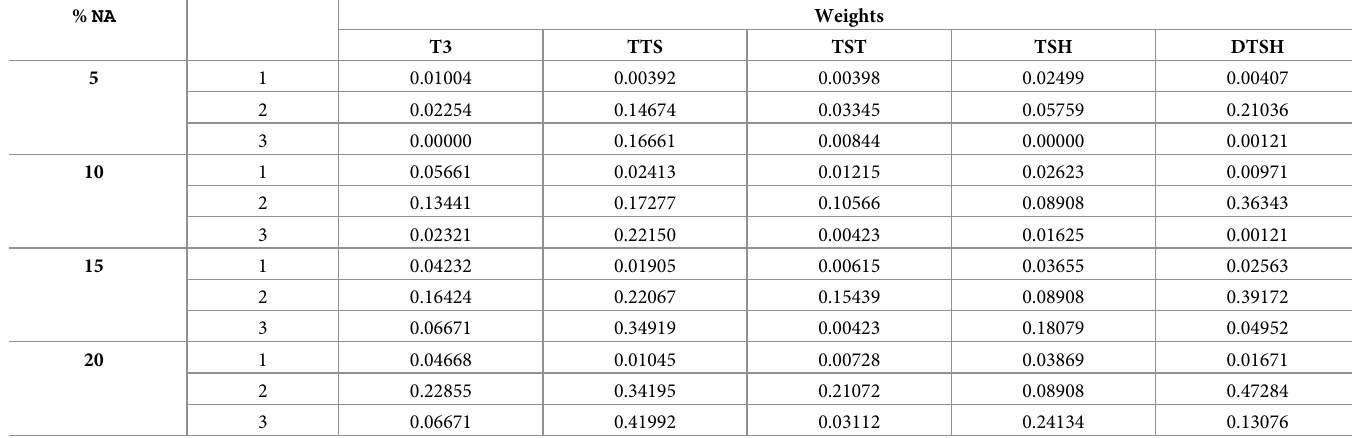
Table 16. Consistency of variables in the VKFCM-K-LP clustering with the imputation of missing values using median values for the Thyroid Gland